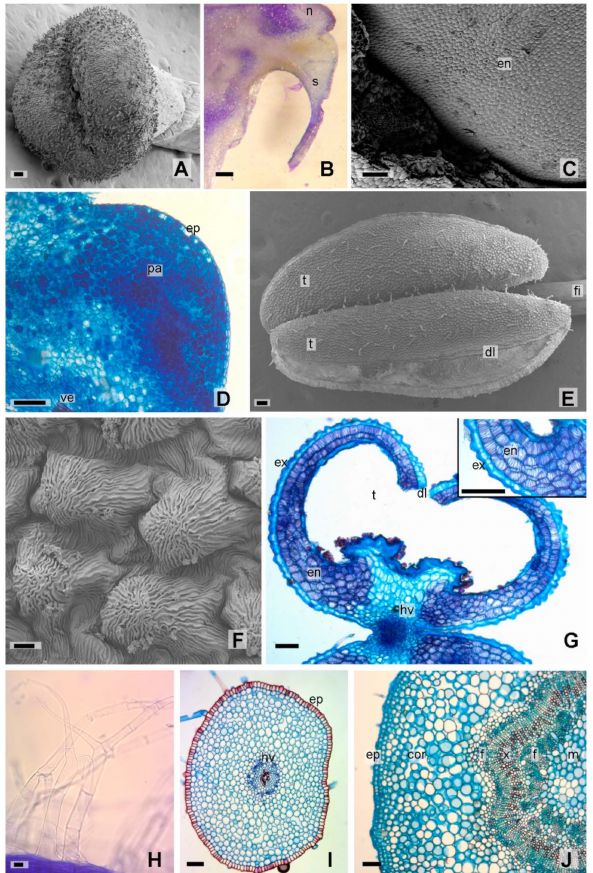
Figure 3. Nicotiana tabacum var. Virginia. ( A – D ) Gynoecium ( A ) Bilobed stigma in SEM. ( B – D ) Floral nectary. ( B ) Cross section. ( C ) Superficial view of the nectary in SEM. ( D ) Detail of the nectary. ( E – I ) Androecium. ( E ) Anther and filament in SEM. ( F ) Detail of the exotecia of the anther in SEM. ( G ) Cross section of anther, insert detail of exo and endothecium. ( H ) Branched trichomes of the filaments. ( I ) Cross section of the filament. ( J ) Cross section of the floral pedicel. References: cor, cortex; dl, longitudinal dehiscence; en, nectariferous stoma; ep, epidermis; f, phloem; fi, filament; hv, vascular bundle; m, medulla; n, nectary; pa, parenchyma; s, know it; t, teak; ve, external vascularity; x, xylem. Scales: ( A – E , G , I – J ) 100 µ m; ( F , H ) 10 µ